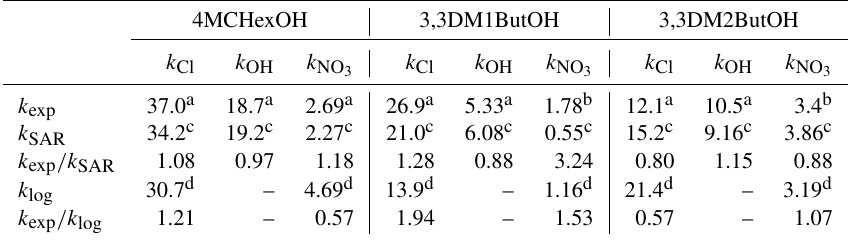
/ 10 − 15 are shown in cubed centimeters per molecule per 3